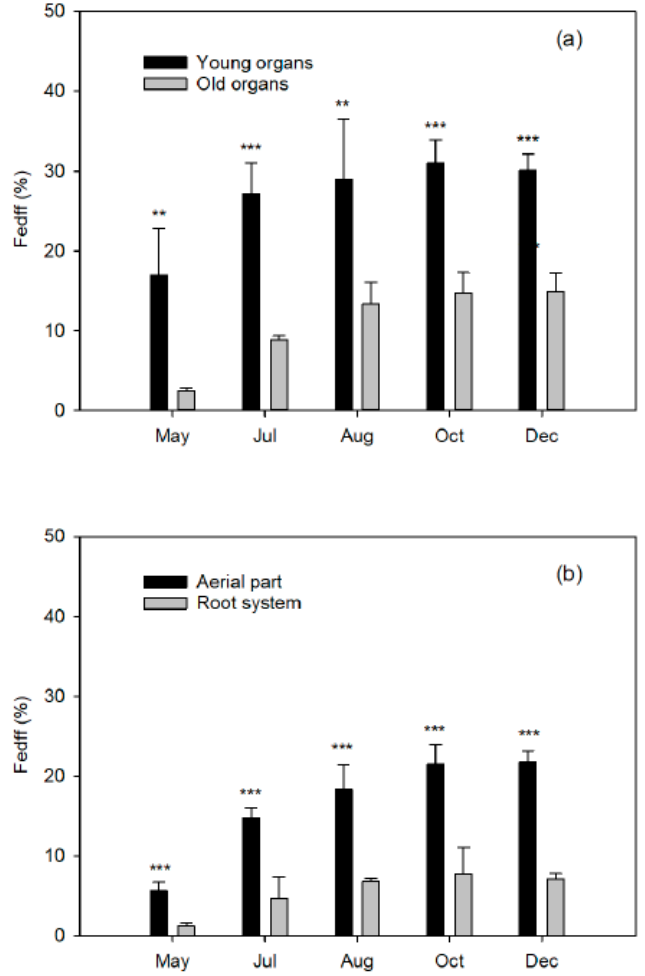
Figure 5. Fe supplied from fertilizer (Fedff W ) in ( a ) young Z and old Y organs from the aerial part in relation to the whole plant and ( b ) aerial part and root system X of Nules clementine trees uprooted in May (flowering), July (fruit set and the end of fruit drop), August (fruit growth), October (fruit growth), and December (fruit maturity). Values are means ±SD (n = 4). Significant effects of Fe dose are given at p ≤ 0.05 (*) and p ≤ 0.001 (***) at each harvest event. Z,Y,X: See Figure 1 W RD Fedff (%) organ = Σ Fedff (mg) organ × 100/ Σ Fedff (mg) plant. W Feddf (%) organ= 57 Fe (%) organ × 100/91.80% 57 Fe.